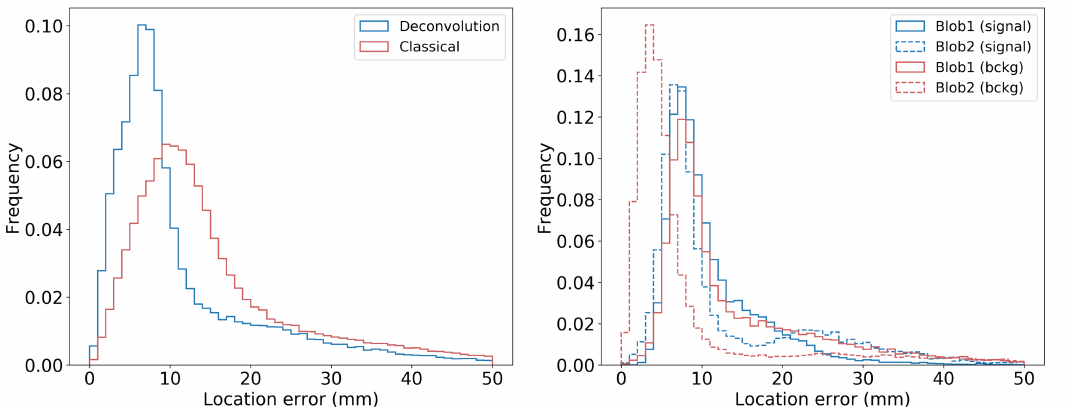
Figure 15 . End-finding error distributions. Left: overall error distributions obtained by RL- deconvolution and the classical analysis for 1.6 MeV double escape peak events; right: distributions for RL-deconvolution divided into signal and background events, with subdivision into blob1 and